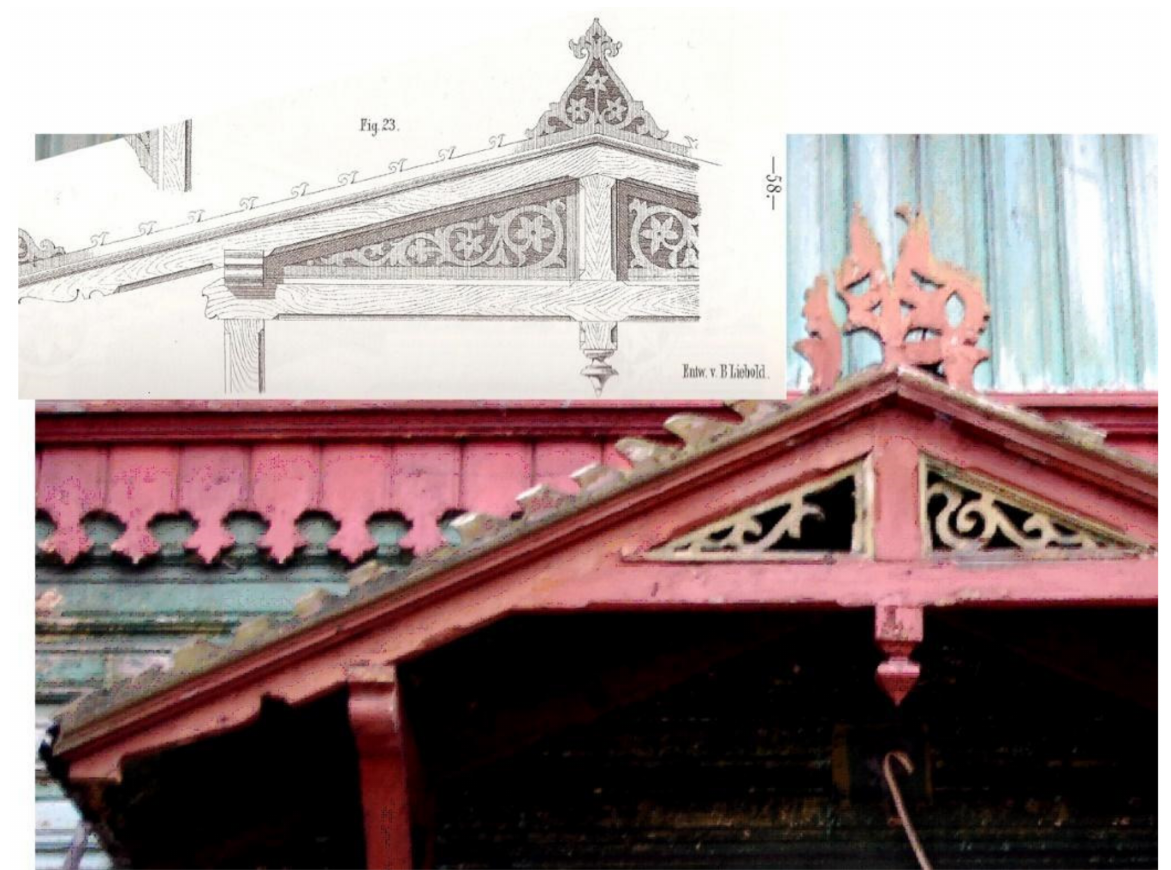
Figure 1. A card from the pattern book of B. Liebold (1893) presenting an example of a decorative wooden gable and decorative roof over the entrance to the Gurewicz Pension (1906) in Otwock; photo: W. Lach,